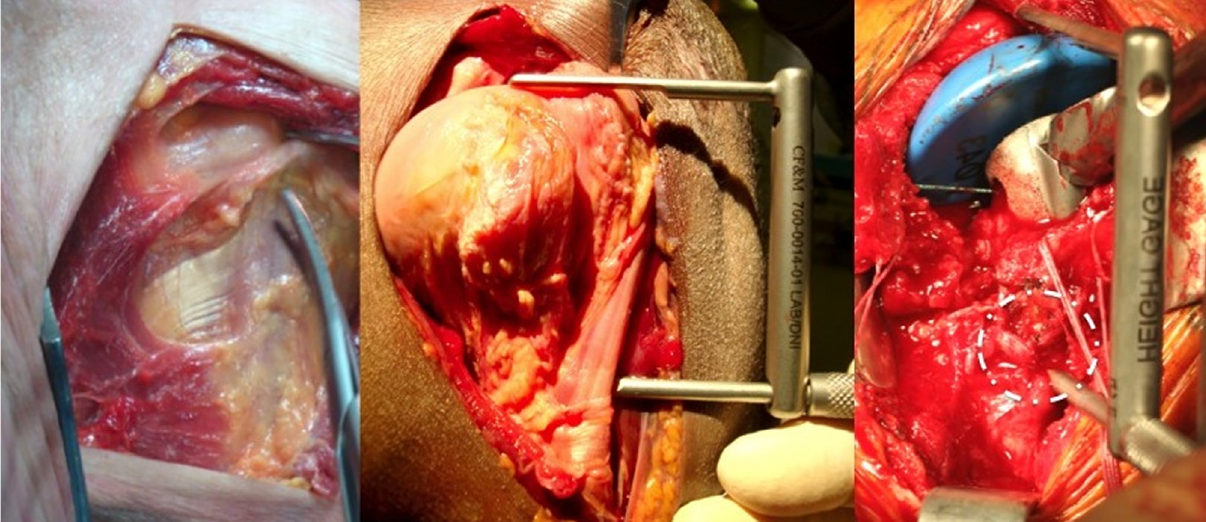
Figure 1. Three examples on left shoulders of the distance apex of the humeral head/upper edge of the pectoralis major: On the left, it is easy to find the upper edge of the pectoralis major on this anatomical dissection, in the center, one can see the scale of a specific measurement tool (with an arbitrary spread of 5.5 cm) measuring the distance between the apex of the humeral head/upper edge of the pectoralis major, on the right, a per-operative view of the positioning of the implant at a good distance from the upper edge of the pectoralis major (circled in